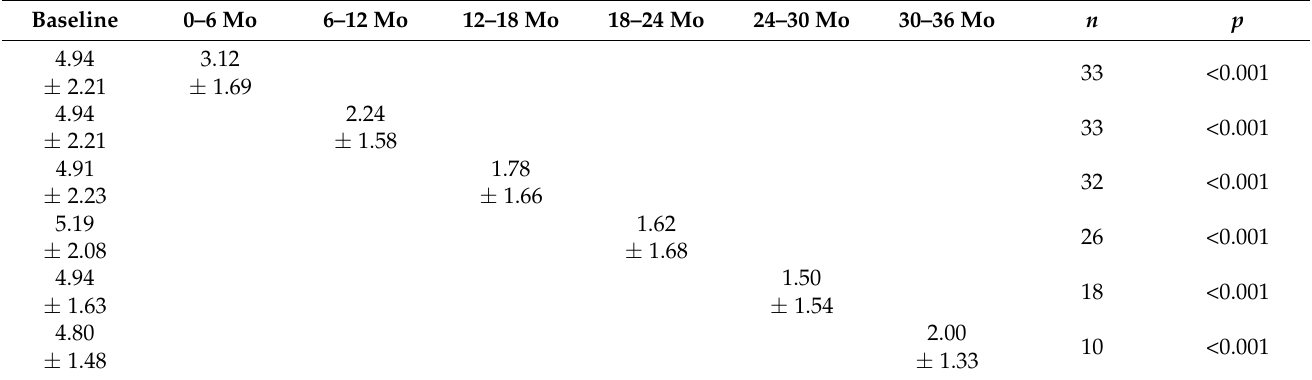
Table 5. Lund–Kennedy endoscopy score (paired t